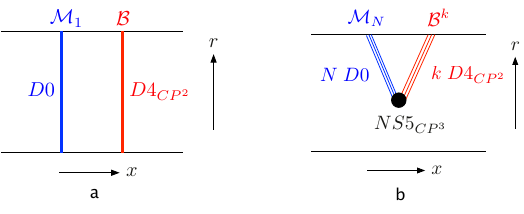
Figure 3 . A holographic description of (a) a dressed monopole and a di-baryon, and (b) the k = relation , in the (U( N ) k B M (cid:0) N